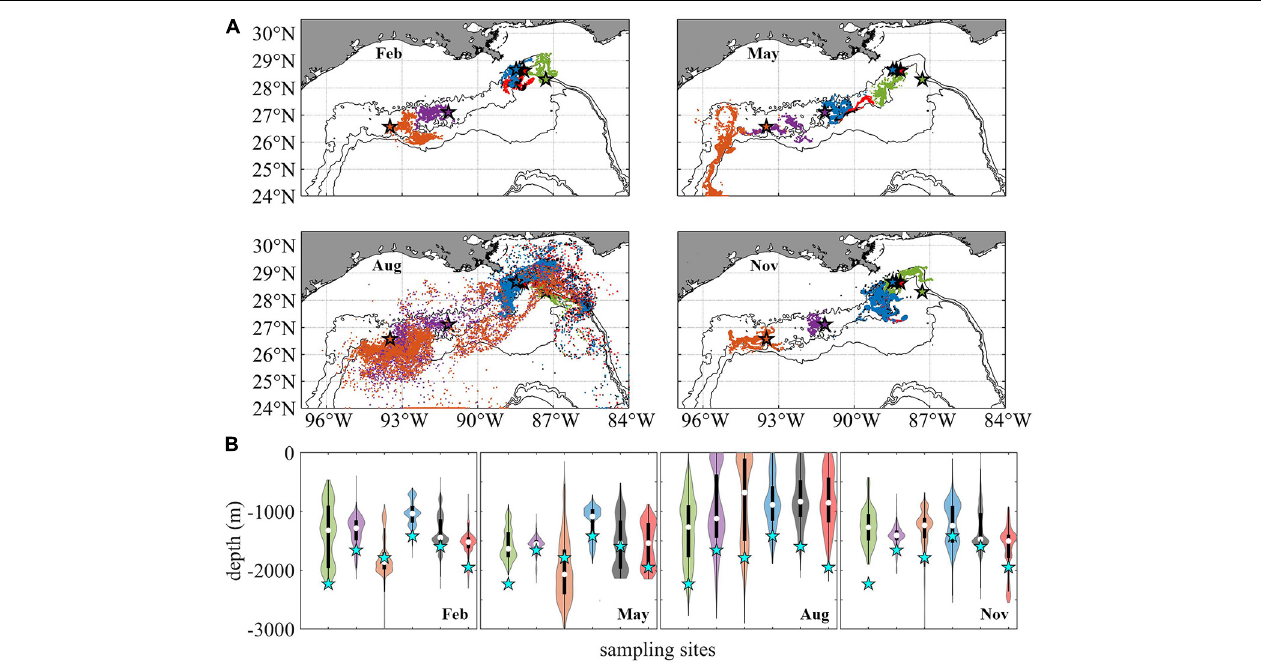
FIGURE 5 | Distribution of Lagrangian larval particles released at the sampling sites after 56 days. Horizontal (A) . Vertical (B) . Particles from different sites in panel (A) are colored consistently with previous figures. For each violin in panel (B) the central white square indicates the median, and the bottom and top edges of the black box indicate the interquartile range between 25th and 75th percentiles, respectively. Thin black line shows 95% confidence level, and cyan stars indicate the initial release depth for each site. The width of each violin represents frequency, i.e., density plot.